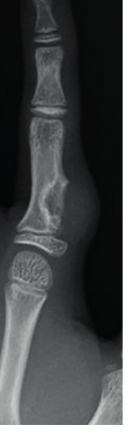
Figure 2: Anteroposterior radiograph reveals saucerization of the underlying cortex and a rim of sclerosis on the radial surface of the proximal phalanx.